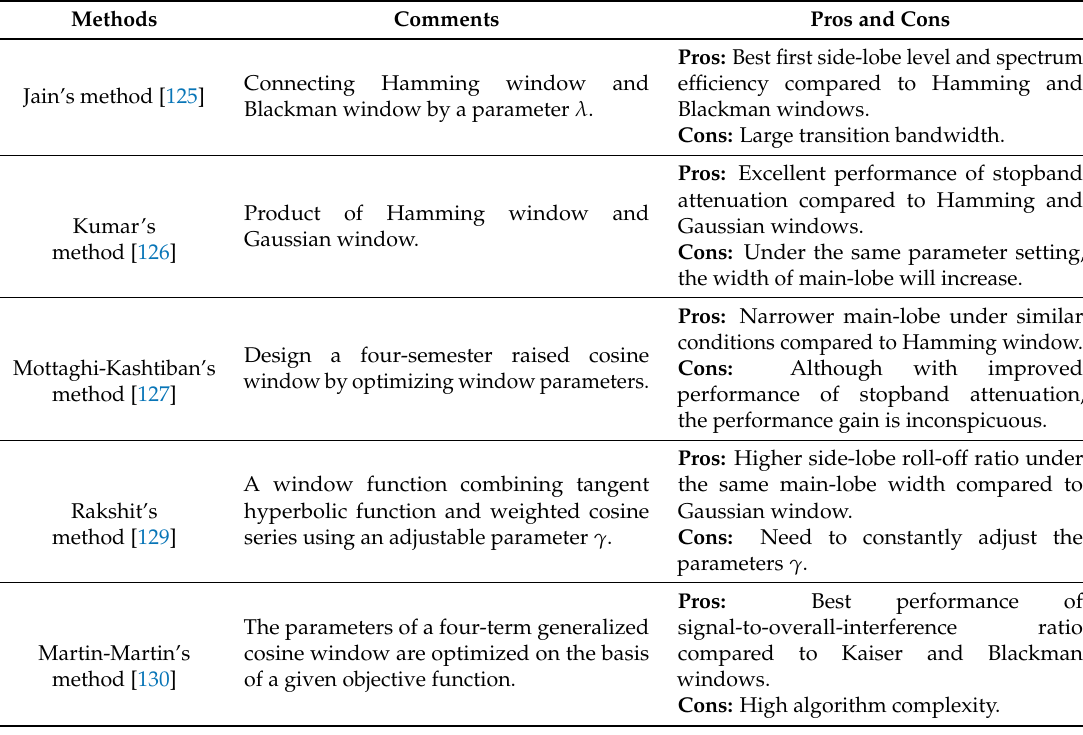
Table 3. Summary of windowing based